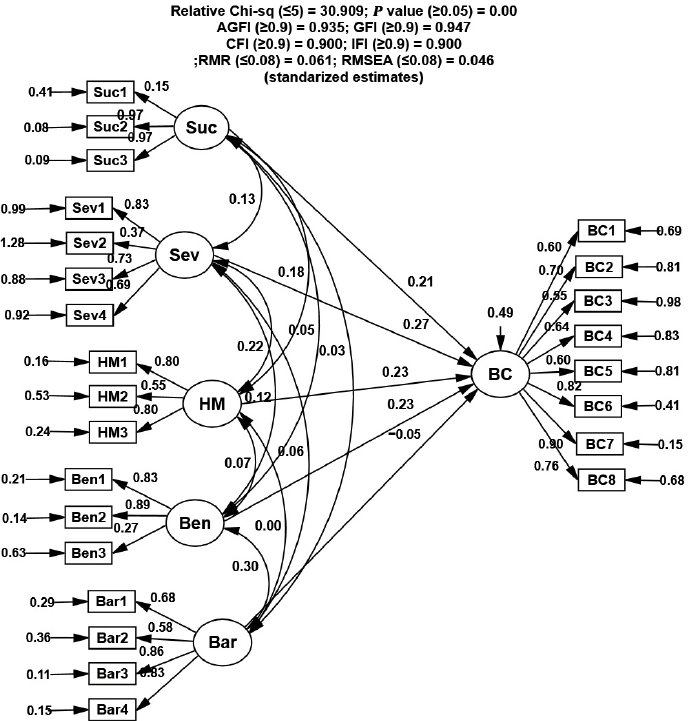
Figure 2. Standardized path coefficients of the factors that directly and indirectly affect intention to receive COVID-19 vaccine in Morocco. Suc—perceived susceptibility; Sev—severity of COVID-19; Bar—perceived barriers; Ben—perceived benefits; SE—self-efficacy; CtA—cues to action; Int—intention to receive COVID-19 vaccine; significant at p < 0.001